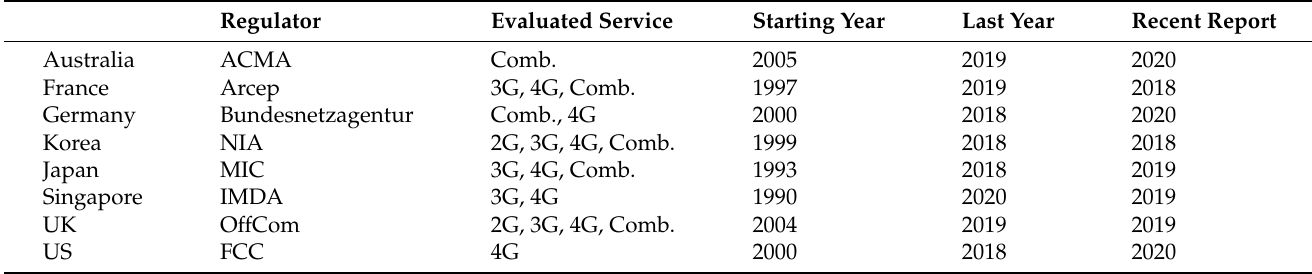
Table 2. History of mobile broadband performance